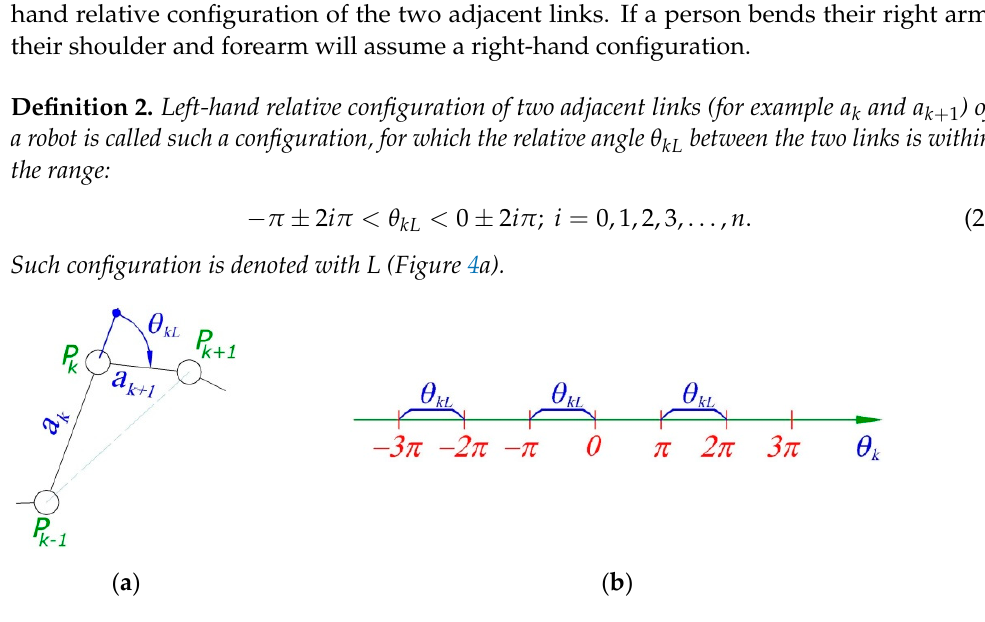
Figure 4. ( a ) Left-hand relative configuration L between two links of a serial robot. ( b ) Intervals in which the angle θ k changes in the left-hand configuration represented on a numerical